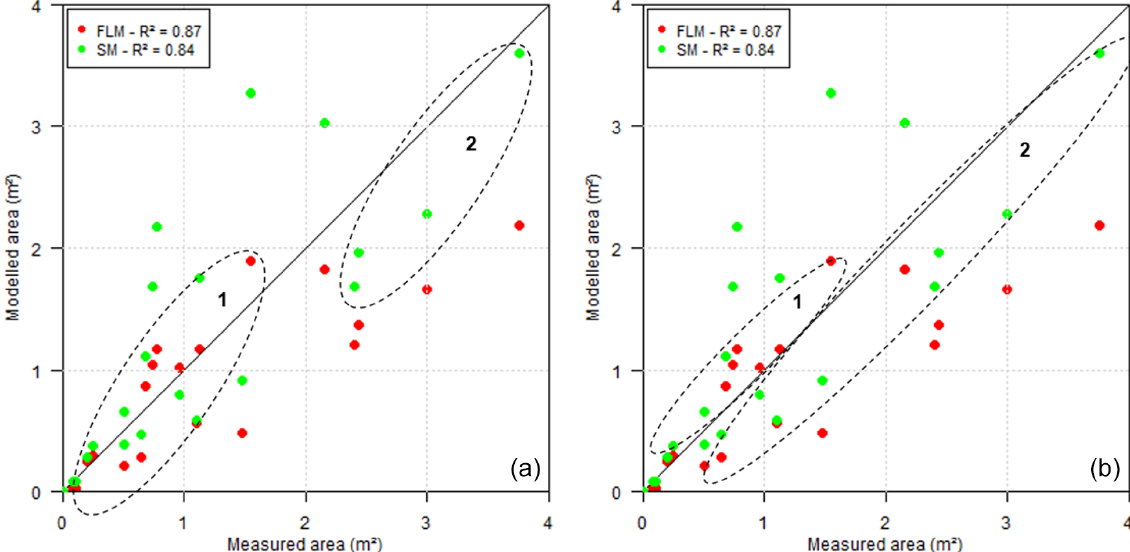
Figure 9. Thresholds for wall erosion (a) based on the cross-section area and (b) based on the catchment geometry and K F . In both plots, set 1 indicates the domain of bed erosion and the Foster and Lane (1983) equations, and set 2 indicates the domain of wall erosion and the Sidorchuk (1999) equations. p value < 0 .